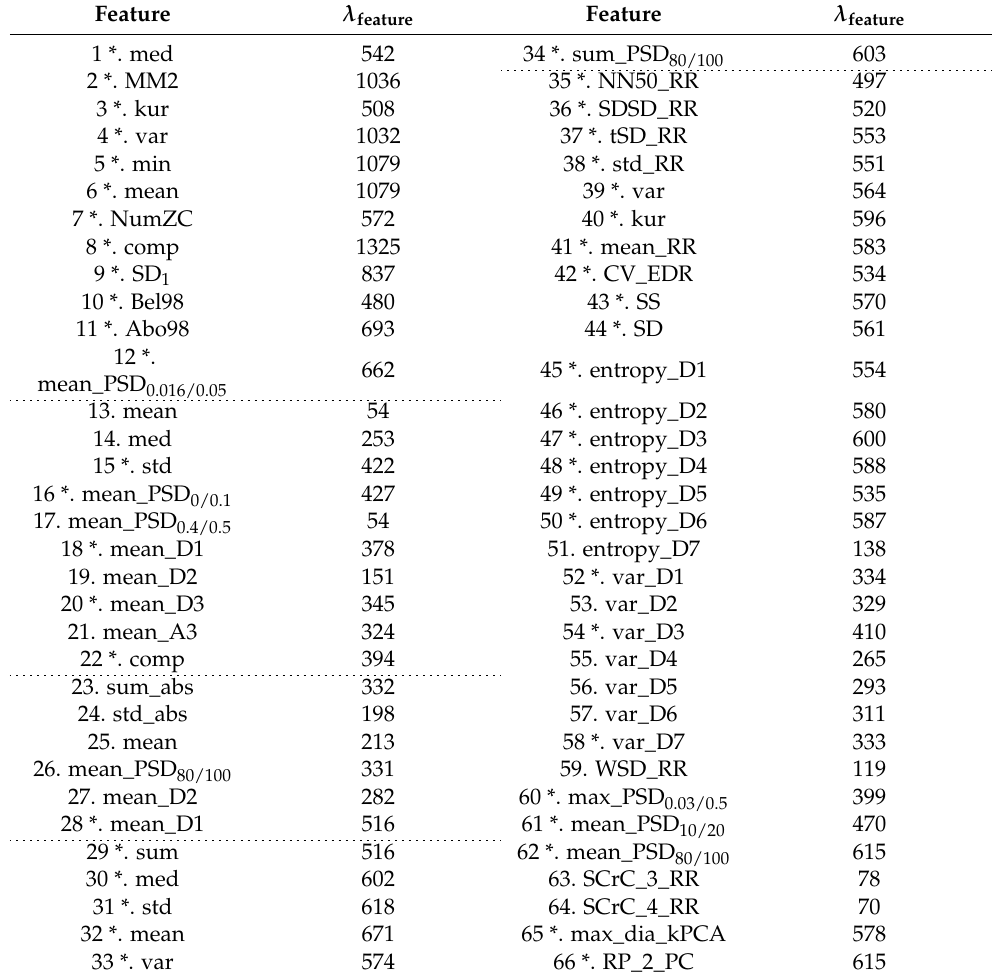
Table 7. Feature selection results in the experiment with time-window using statistical analysis (features 1–12 from the SaO 2 signals, features 13–22 from the airflow signals, features 23–28 from the abdominal signals, features 29–34 from the thoracic signals, and features 35–66 from the ECG signals; four dashed lines divide the table into five parts according to the kind of signals); * denotes selected best feature